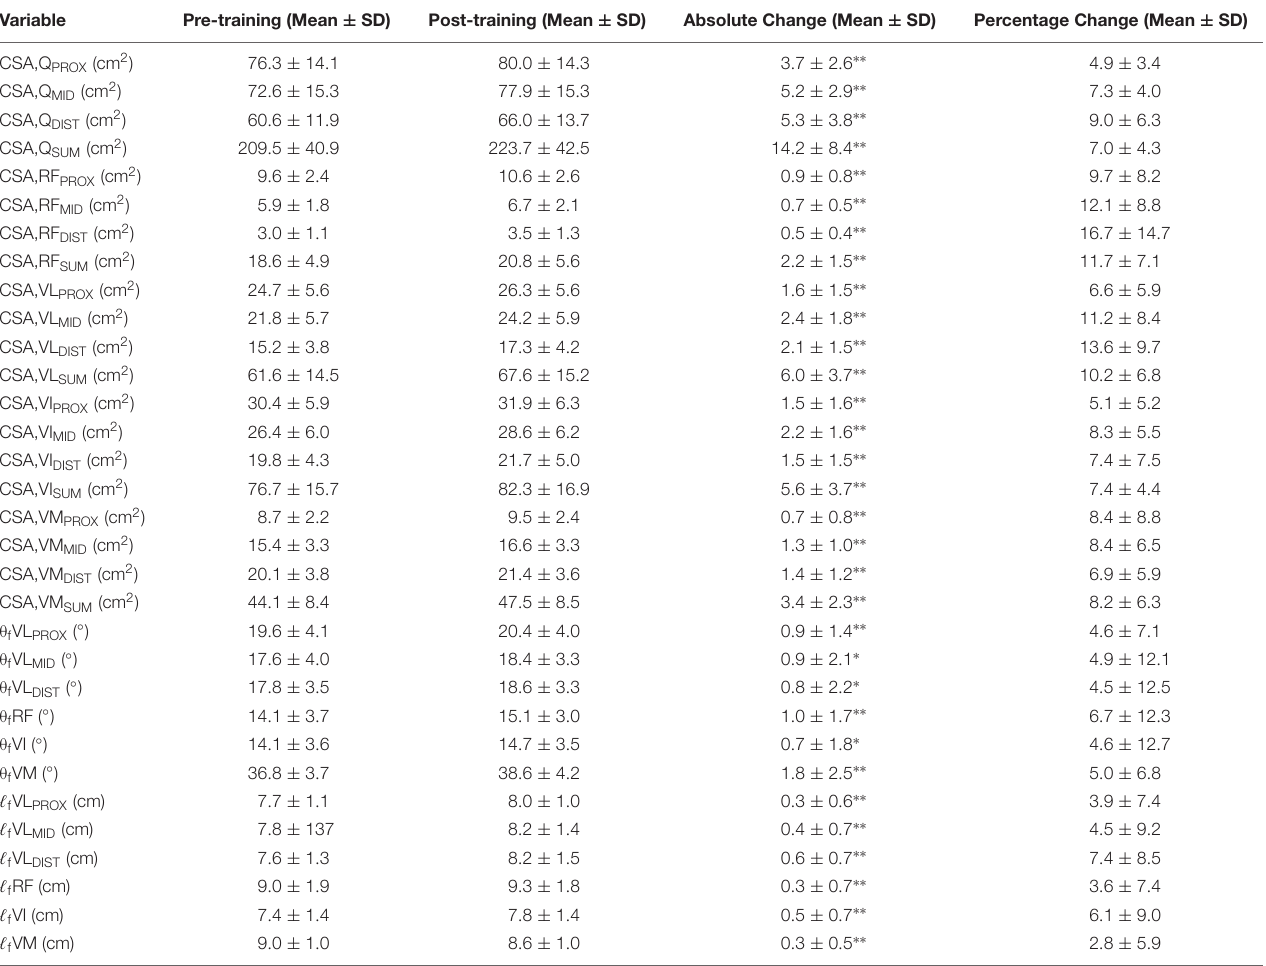
TABLE 2 | Muscle size, fascicle angle, and fascicle length obtained before and after training. Variable Pre-training (Mean ± SD)